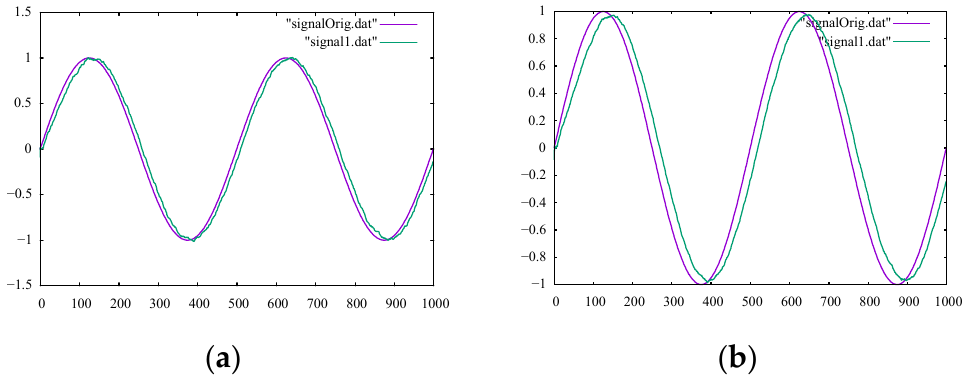
Figure 4. The output of the Kalman filter with the ground-truth sine signal for comparison using ( a ) E mea = 0.01 and ( b ) E mea = 0.02.